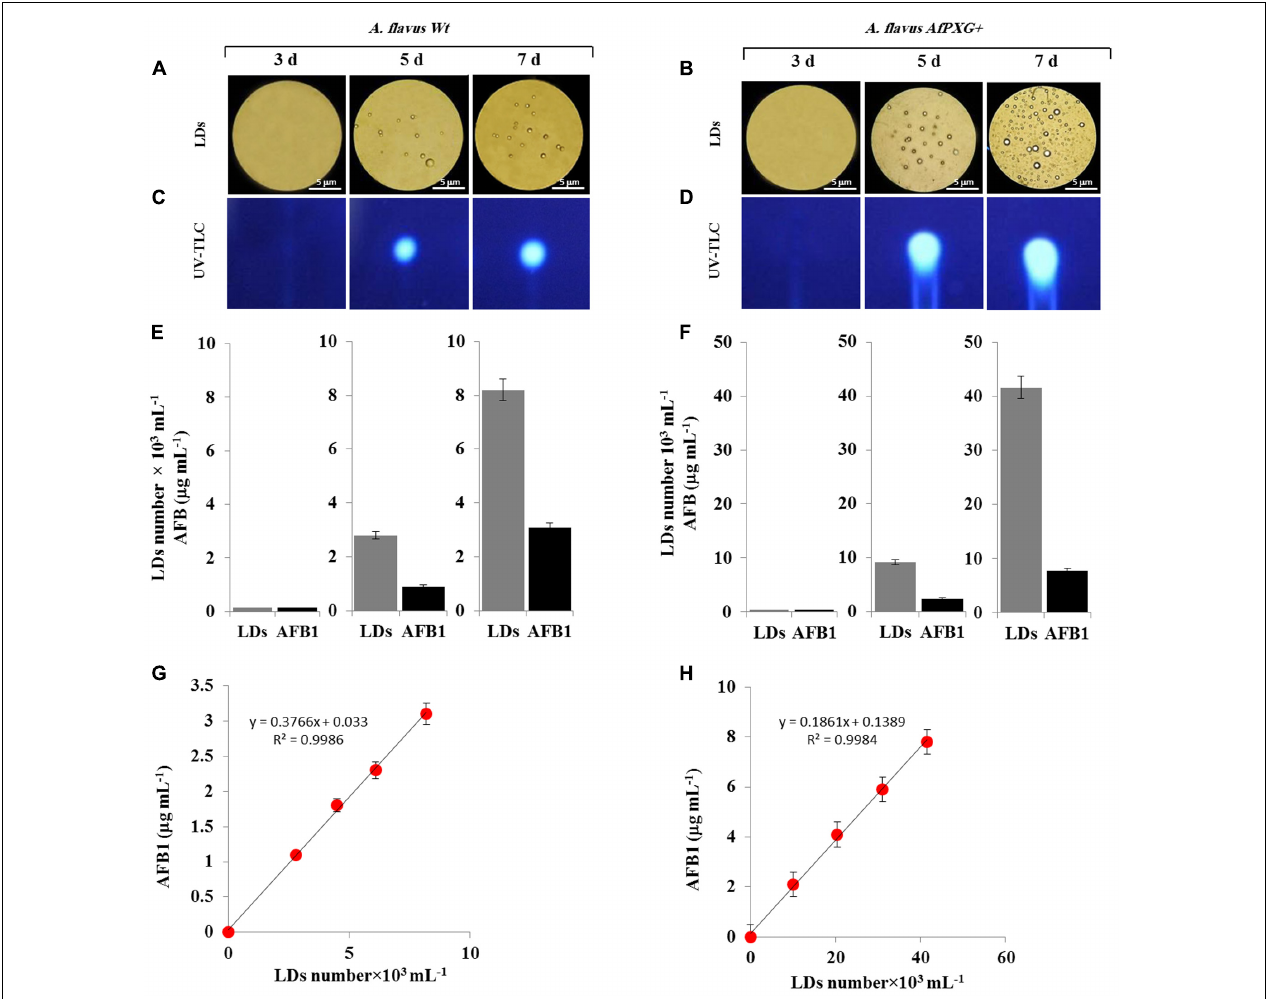
FIGURE 5 | Purified and stable lipid droplets (LDs) isolated from the line AfPXG+ effectively sequester AF. (A,B) Light micrographs of isolated LDs from fungal tissue of A. flavus WT or A. flavus AfPXG+ line, respectively, on days 3, 5, and 7. Purified LDs suspended in 100 mM potassium pyrophosphate, pH 7.4 were observed under a LEICA MPS60 microscope and images were taken at a magnification of 40 × . Bar represents 5 mm. (C,D) TLC-analysis of AFB1 in LD fractions isolated from WT and AfPXG+ lines. (E,F) Quantitative data for LD number and content of AFB1 in fractions isolated from WT and AfPXG+ lines. (G,H) Linear relationship between the number of LDs and their AFB1 content. AFB1 was extracted and analyzed by UV-HPLC as described in Section “Materials and Methods.” Measurements were done in triplicate. Values are the means ± SD ( n =